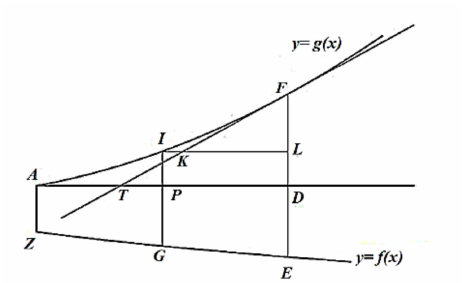
Figure 5. Fundamental